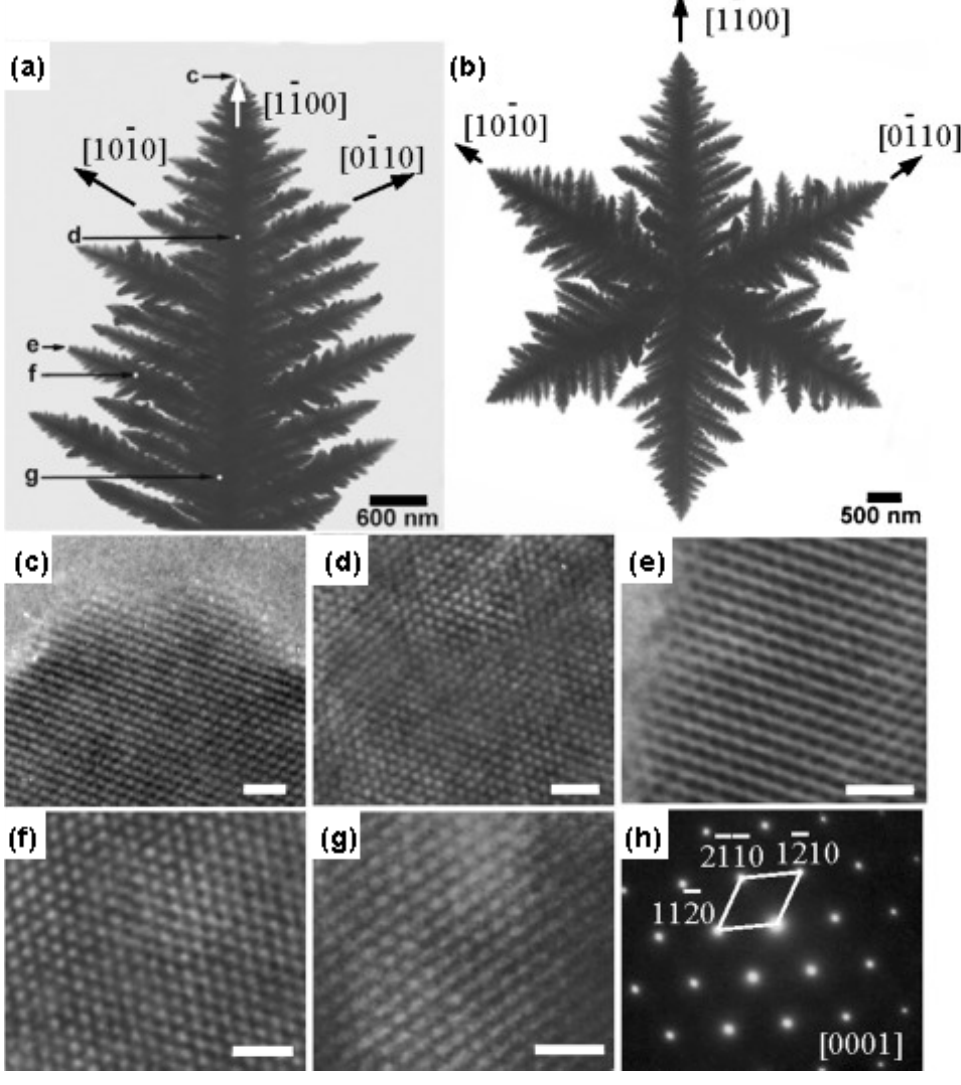
Figure 9. TEM of a fractal exhibiting hyperbranches of α -Fe 2 O 3 fractals. ( b ) TEM image of a sixfold-symmetric dendritic structure. ( c – g ) High-resolution TEM images recorded in different regions of the dendritic structure in ( a ) showing the well-defined single-crystalline nature of the entire dendritic structure (scale bar: 1 nm). ( h ) Electron diffraction pattern recorded from the entire dendritic structure in ( a ) which also shows the single-crystalline nature of the entire dendritic structure. Reproduced from Ref. [102] with permission from Wiley-VCH, 2005.